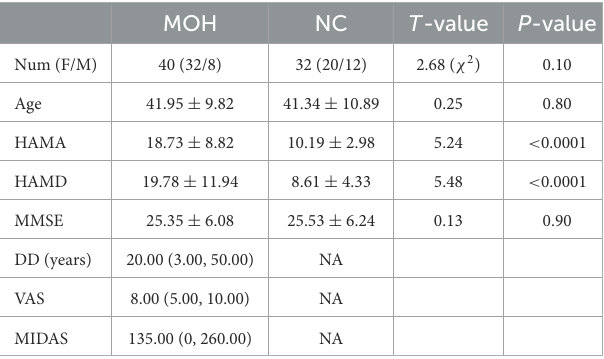
TABLE 1 Demographic and clinical characteristics of the subjects.